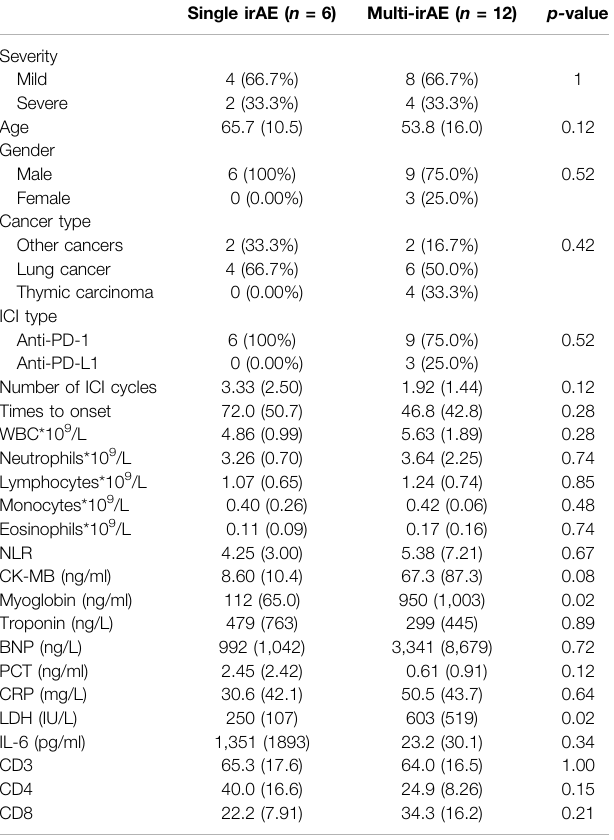
TABLE 4 | Comparison of myocarditis patients with single irAE or multi-irAE.